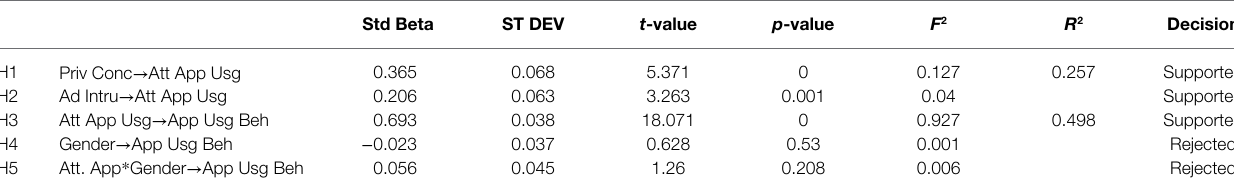
TABLE 4 | Hypotheses testing